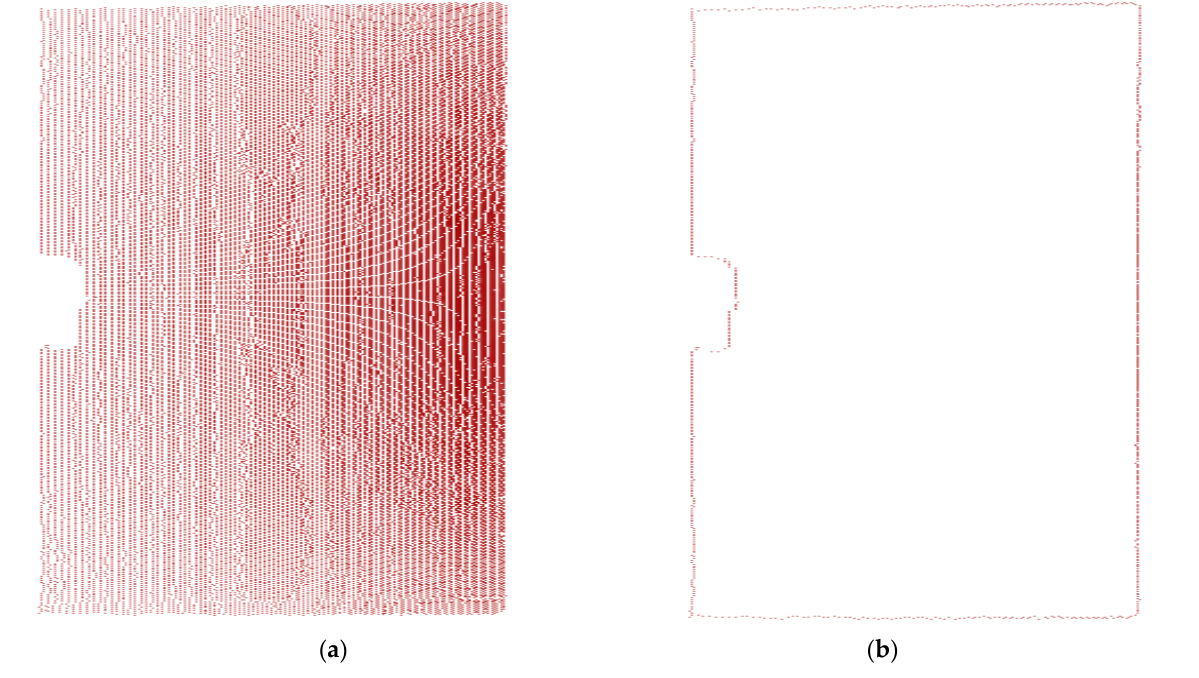
Figure 3. Boundary points extraction where ( a ) raw point cloud and ( b ) boundary points extraction results.